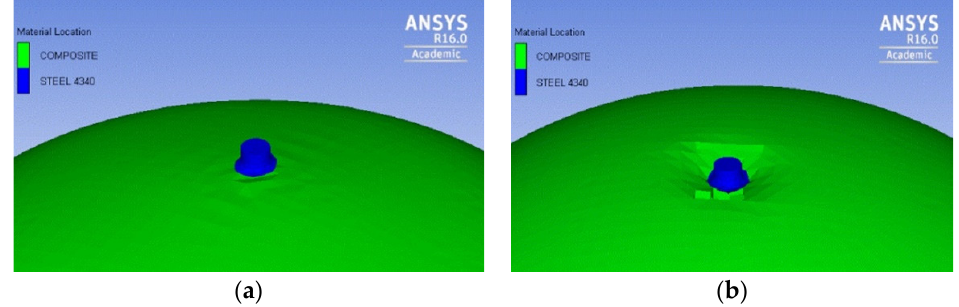
Figure 8. The fragment simulating projectile (FSP) impacted at the top of the helmet with velocity of ( a ) 610 m s − 1 and ( b ) 670 m s − 1 .